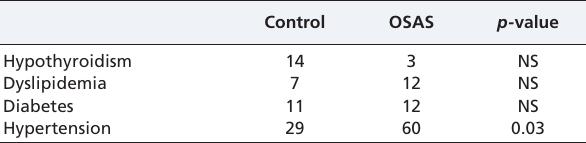
Table 2 - Number of individuals with relevant comorbidities in both